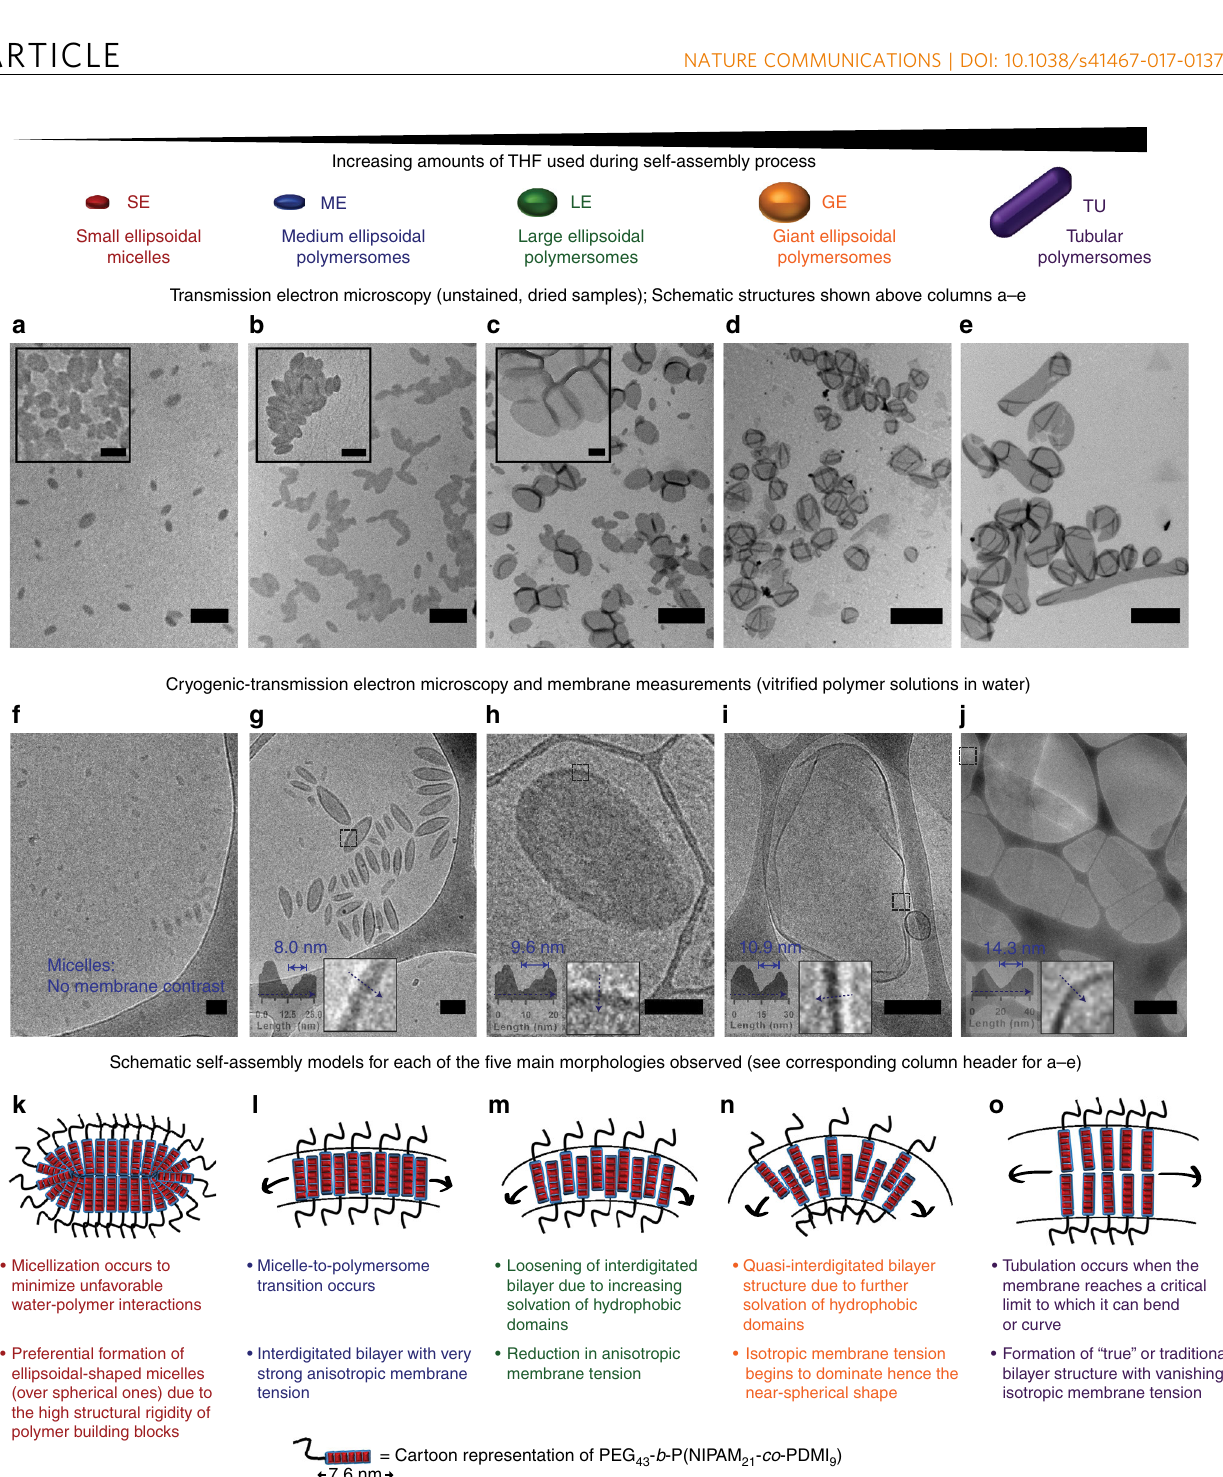
micelles and lamellar structures exists in solution.